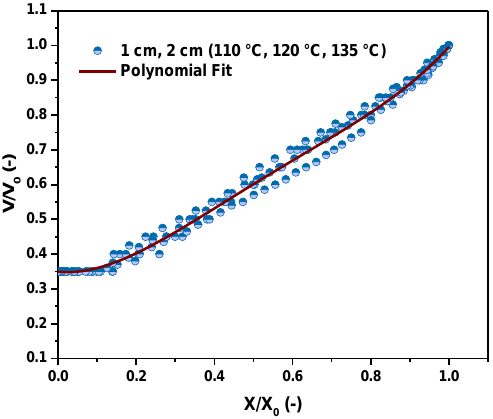
Figure 6. Variation of volume versus the reduced moisture content.